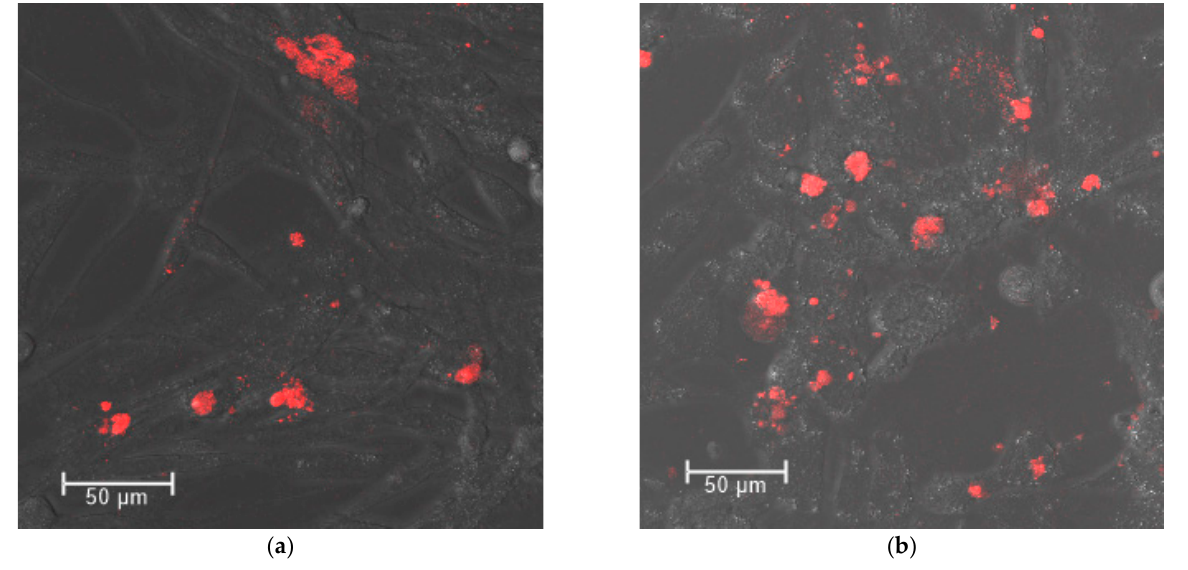
Figure 7. Confocal images of 9LGS cells at 63× magnification exposed to either ( a ) 50 or ( b ) 100 ug/mL of the gold suspension for 24 h. The red areas are the detection of the AF647 fluorophore attached to the nanoparticle against the bright field.